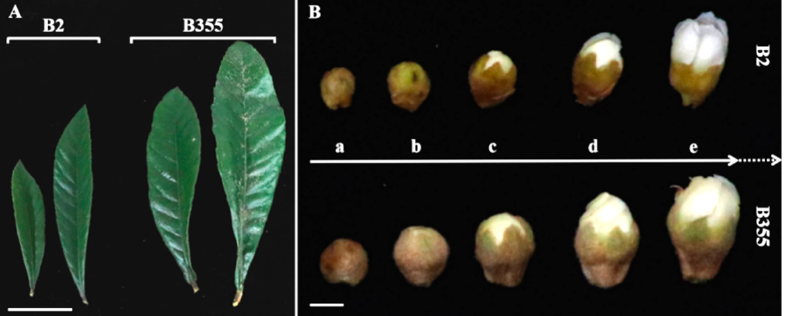
Figure 1. Comparison of leaf and flower bud size between B2 and B355 loquat. ( A ) Leaf size difference between B2 and B355 loquat. Scale, 5 cm. The leaves of annual summer shoots and spring shoots are shown on left and right, respectively. ( B ) Differences in the flower buds of B2 and B355 loquat. a–e represent development stages. Scale, 5 mm → represents the development process.